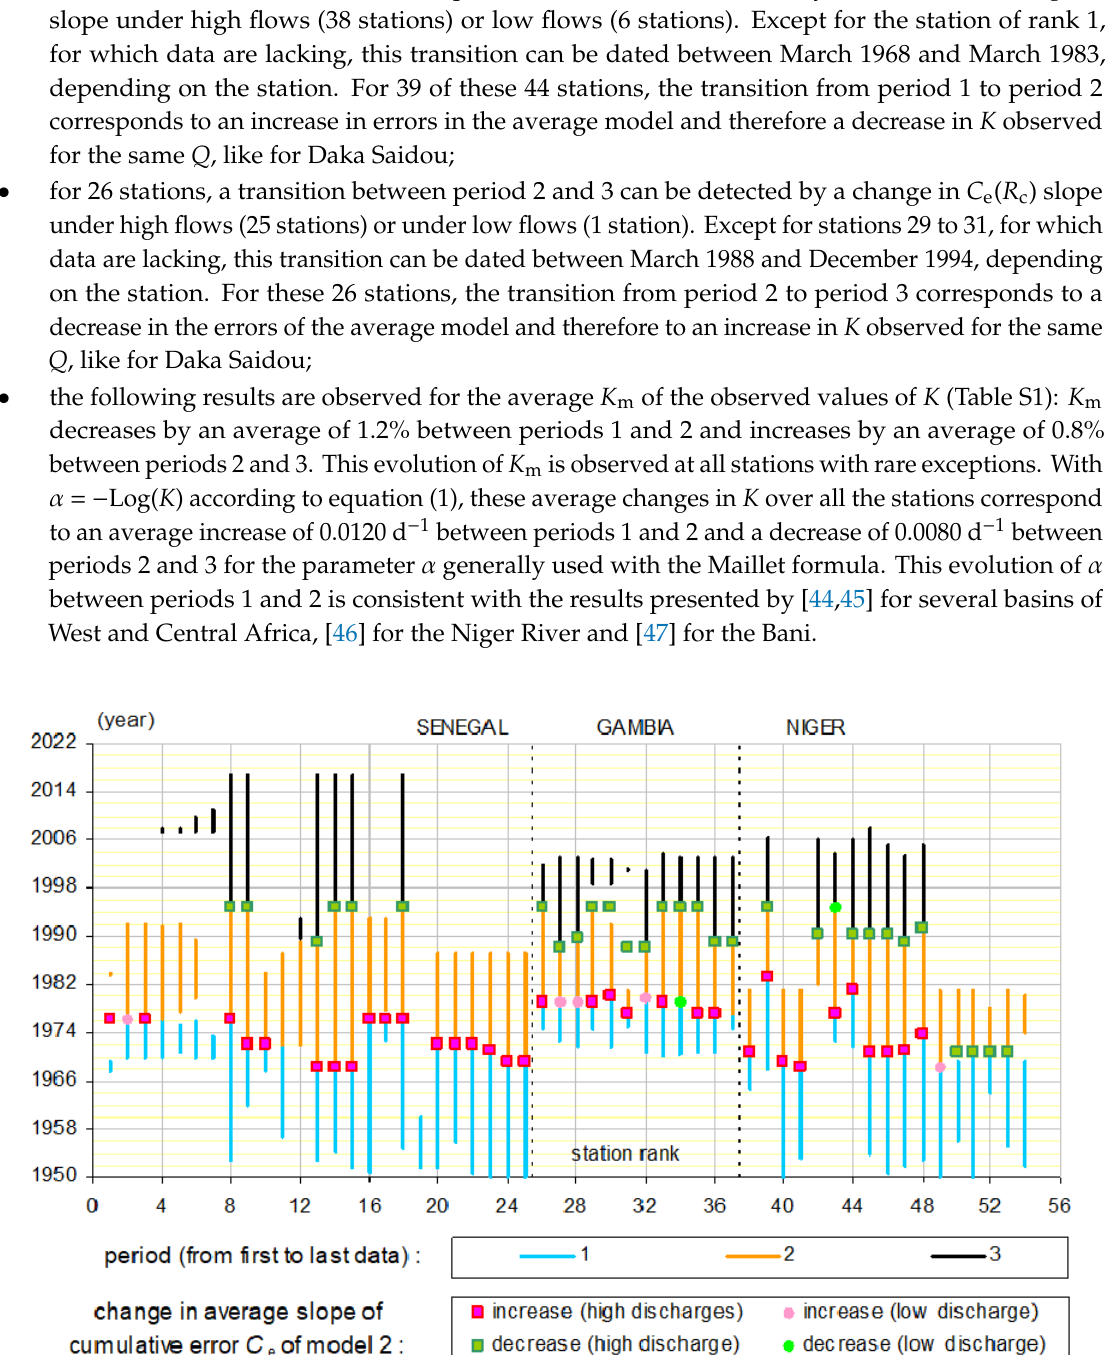
Figure 14. Model 2 representing K as a function of discharge Q , calibrated on successive periods 1 to 3 and on the overall period, for the Bafing at Daka Saidou (station 8), with abscissa in logarithmic values on the left ( a ) and natural values on the right ( b ).